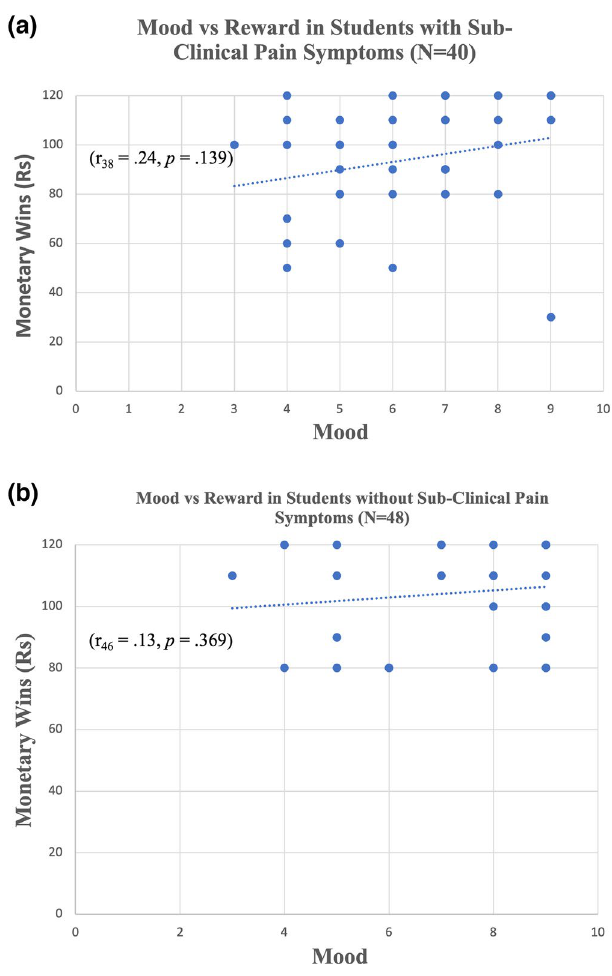
Figure 2. Correlations between the mean mood scores and the amount of monetary reward received. The following different figures demonstrate the correlations between the mean mood scores and the amount of monetary reward. The value of the y-axis shows the sum win (in Rs) obtained by adding the monetary wins in reward conditions. The subjects as represented as dots (blue circle). ( a ) Correlation between mean mood scores and the amount of monetary reward received in the control group without clinically significant pain symptoms of pain (N = 48). The results indicate that there was no significant correlation found (r 46 = 0.13, p = 0.369). ( b ) Correlation between mean mood scores and the amount of monetary reward received in the sub-clinical group with the symptoms of pain (N = 40). The results indicate that there was no significant correlation found (r 38 = 0.24, p =